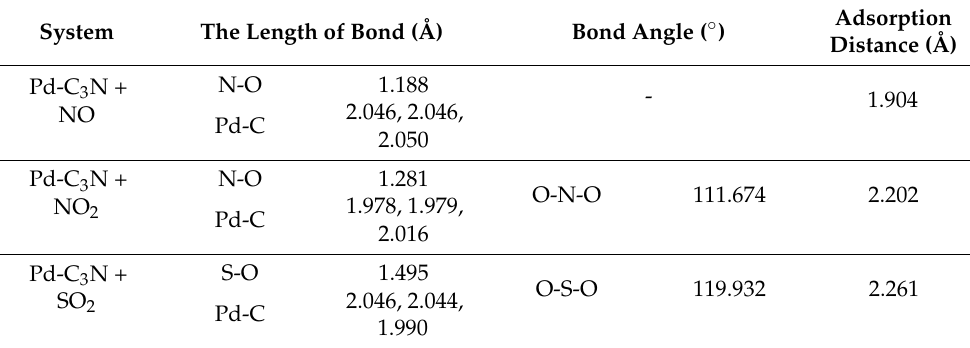
Table 3. The geometrical parameters of three gas adsorption systems.